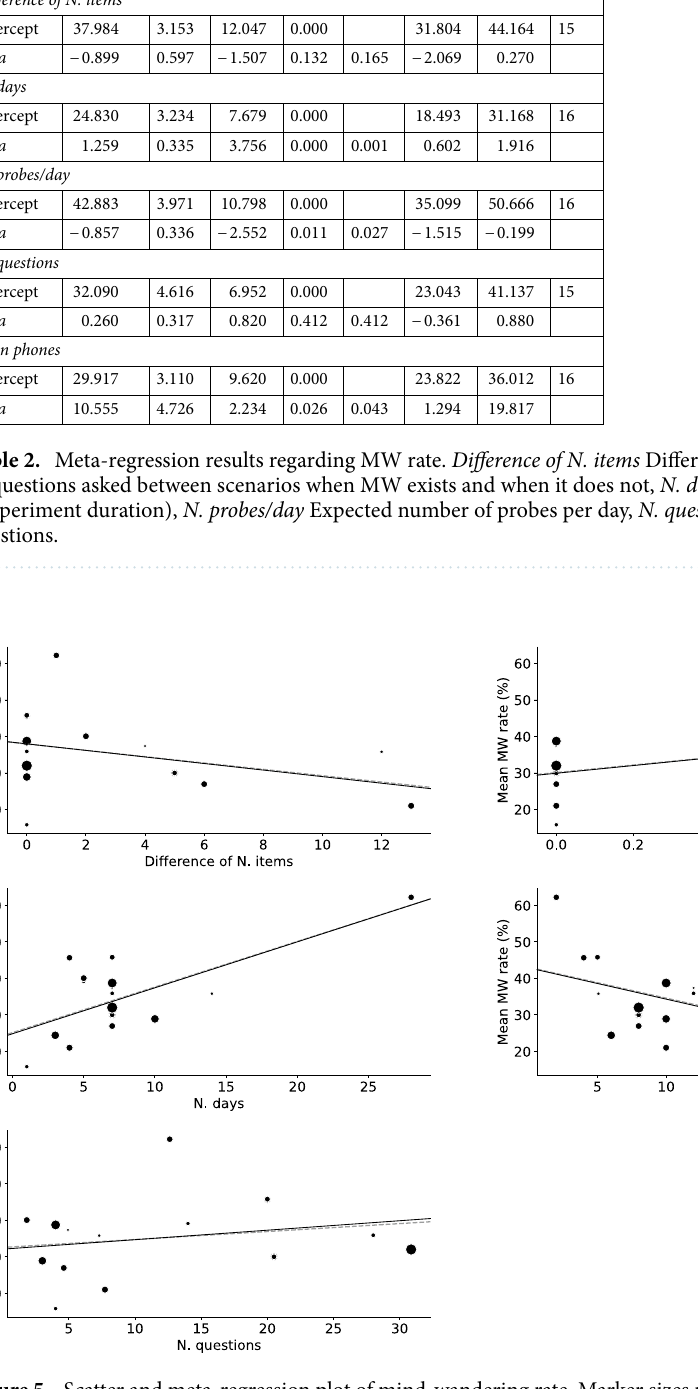
Figure 5. Scatter and meta-regression plot of mind-wandering rate. Marker sizes reflect article sample sizes. The solid line denotes the meta-regression line biased due to article weights. The dashed line denotes the unweighted regression line. N. days Number of days (Experiment duration), N. probes/day Expected number of probes per day, Sub. exclusion rate (%) Rate of excluded subjects to recruited subjects, Thr. of compliance (%) Threshold of compliance rate (only if authors used compliance rate as a criterion of subject exclusion), N. questions not when MW Expected number of questions if MW does not exist. N. questions when MW Expected number of questions if MW